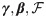
Dependency graph for the phylodynamic model parameters and data.Dependencies labeled 1 are explored in section, those labeled 2 are explored in section, those labeled 3 are explored in section, and those labeled 4 are explored in section. The dashed lines between γ,β,F and s represent preferential sampling.